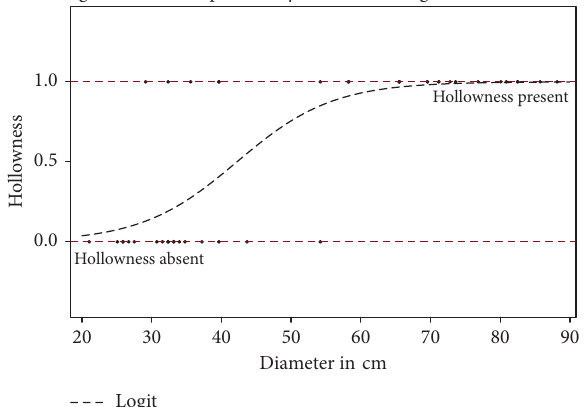
Figure 7: Logistic model curve of the probability of hollowness.